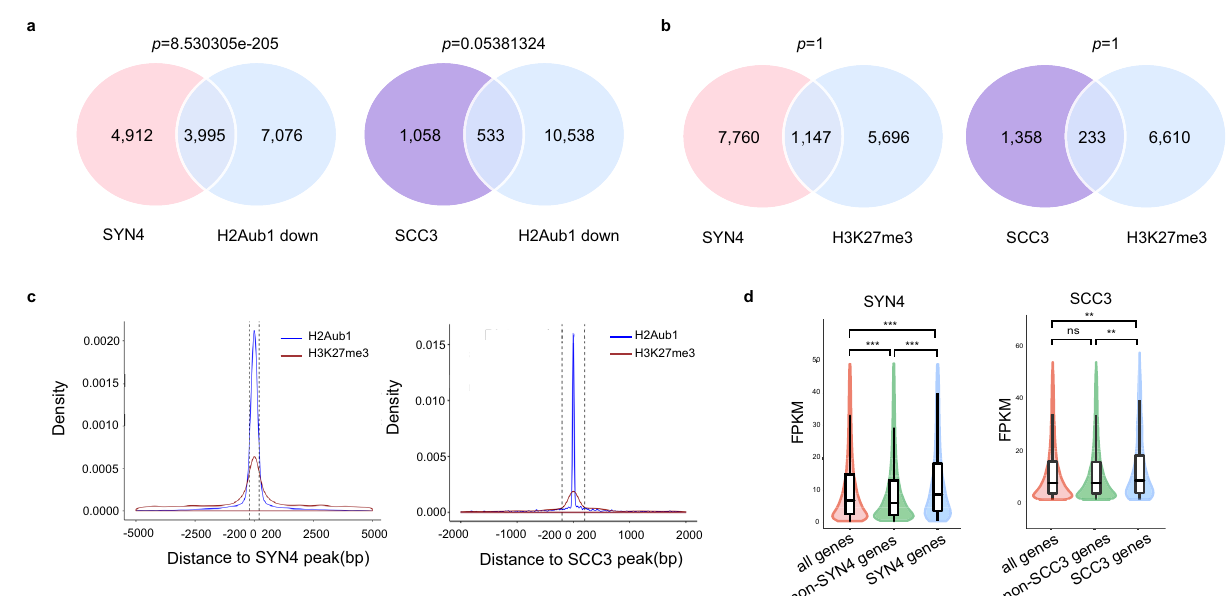
Fig.4|AtSYN4andAtSCC3areassociatedfunctionallywithH2Aub1andactive transcription. a Venn diagram showing the overlaps between the genes with downregulated H2Aub1 levels in atbmi1a/b/c and the genes targeted by AtSYN4 (left) orAtSCC3 (right) in Col-0. Signi fi cancewasexaminedbythe hypergeometric test. b Venn diagrams showing no signi fi cant intersection between genes marked by H3K27me3 and those targeted by AtSYN4 (left) or AtSCC3 (right) in Col-0. Signi fi cance wastested using a hypergeometric test. c Density plots displaying the distances of H2Aub1 and H3K27me3 to the center of AtSYN4 peak (left) or AtSCC3 peak(right).The dottedline represents the average distanceto AtSYN4 or AtSCC3 peak. d Comparisons of the transcription levels between AtSYN4- or AtSCC3-